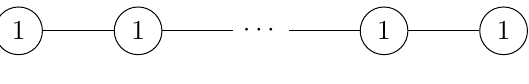
Figure 13 . Abelian A r